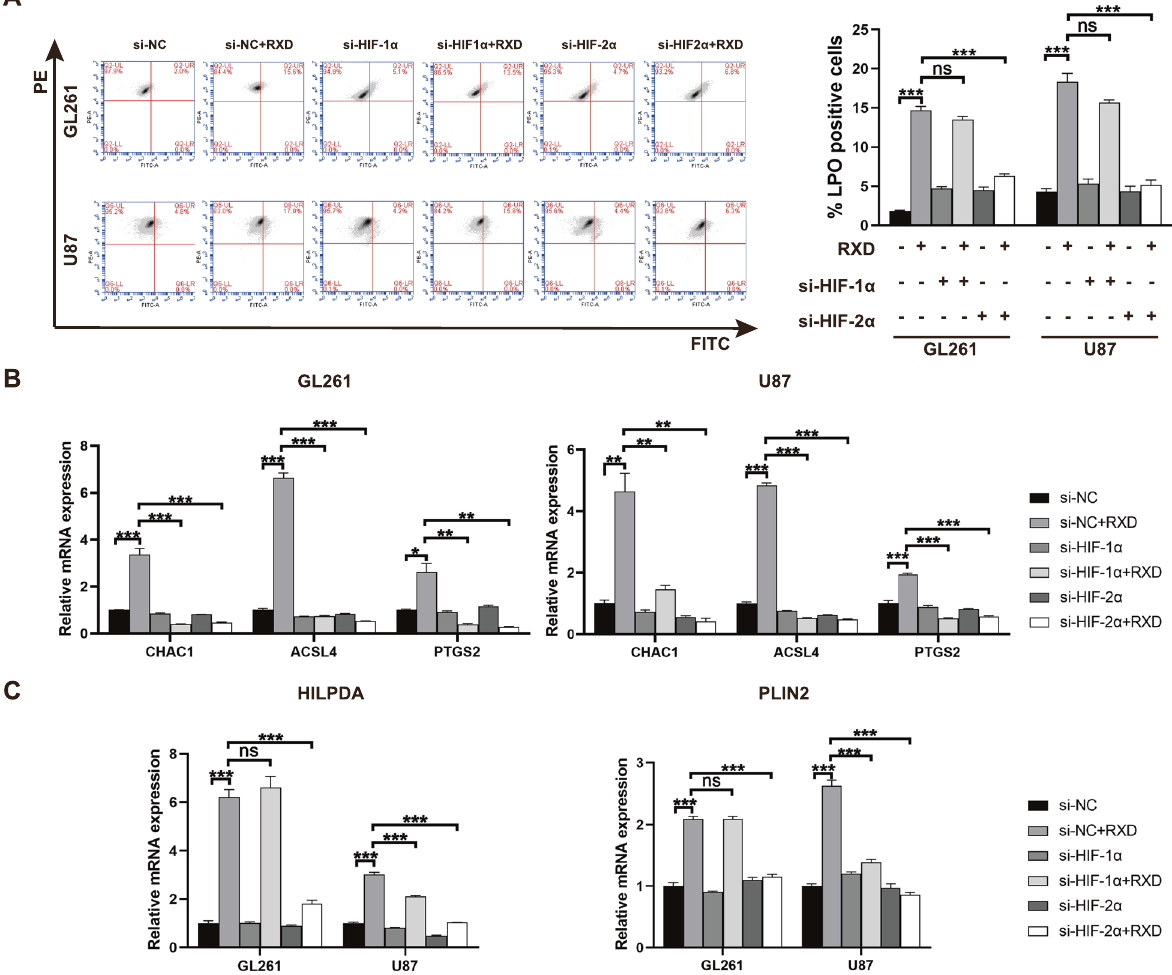
Fig. 8 HIF-2 α activation upregulating lipid genes contributed to excessive lipid peroxidation in roxadustat-induced ferroptosis. A Representative fl ow cytometry analysis and statistical histogram of LPO-positive cells in GL261 or U87 cells transfected with siRNAs for 48 h and with/without RXD treatment (100 μ M towards U87, 200 μ M towards GL261) for 48 h. B Histogram of mRNA expression of CHAC1, ACSL4, and PTGS2 in GL261 or U87 cells with the different treatments. C Histogram of mRNA expression of HILPDA and PLIN2 in GL261 or U87 cells with the different treatments. * P < 0.05, ** P < 0.01, *** P <